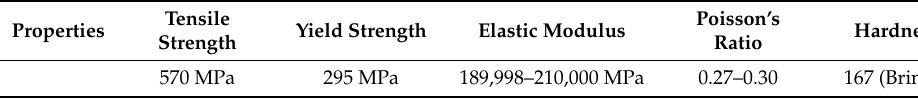
Table 3. Cutting Table 1. General chemical properties of AISI 5140 steel.